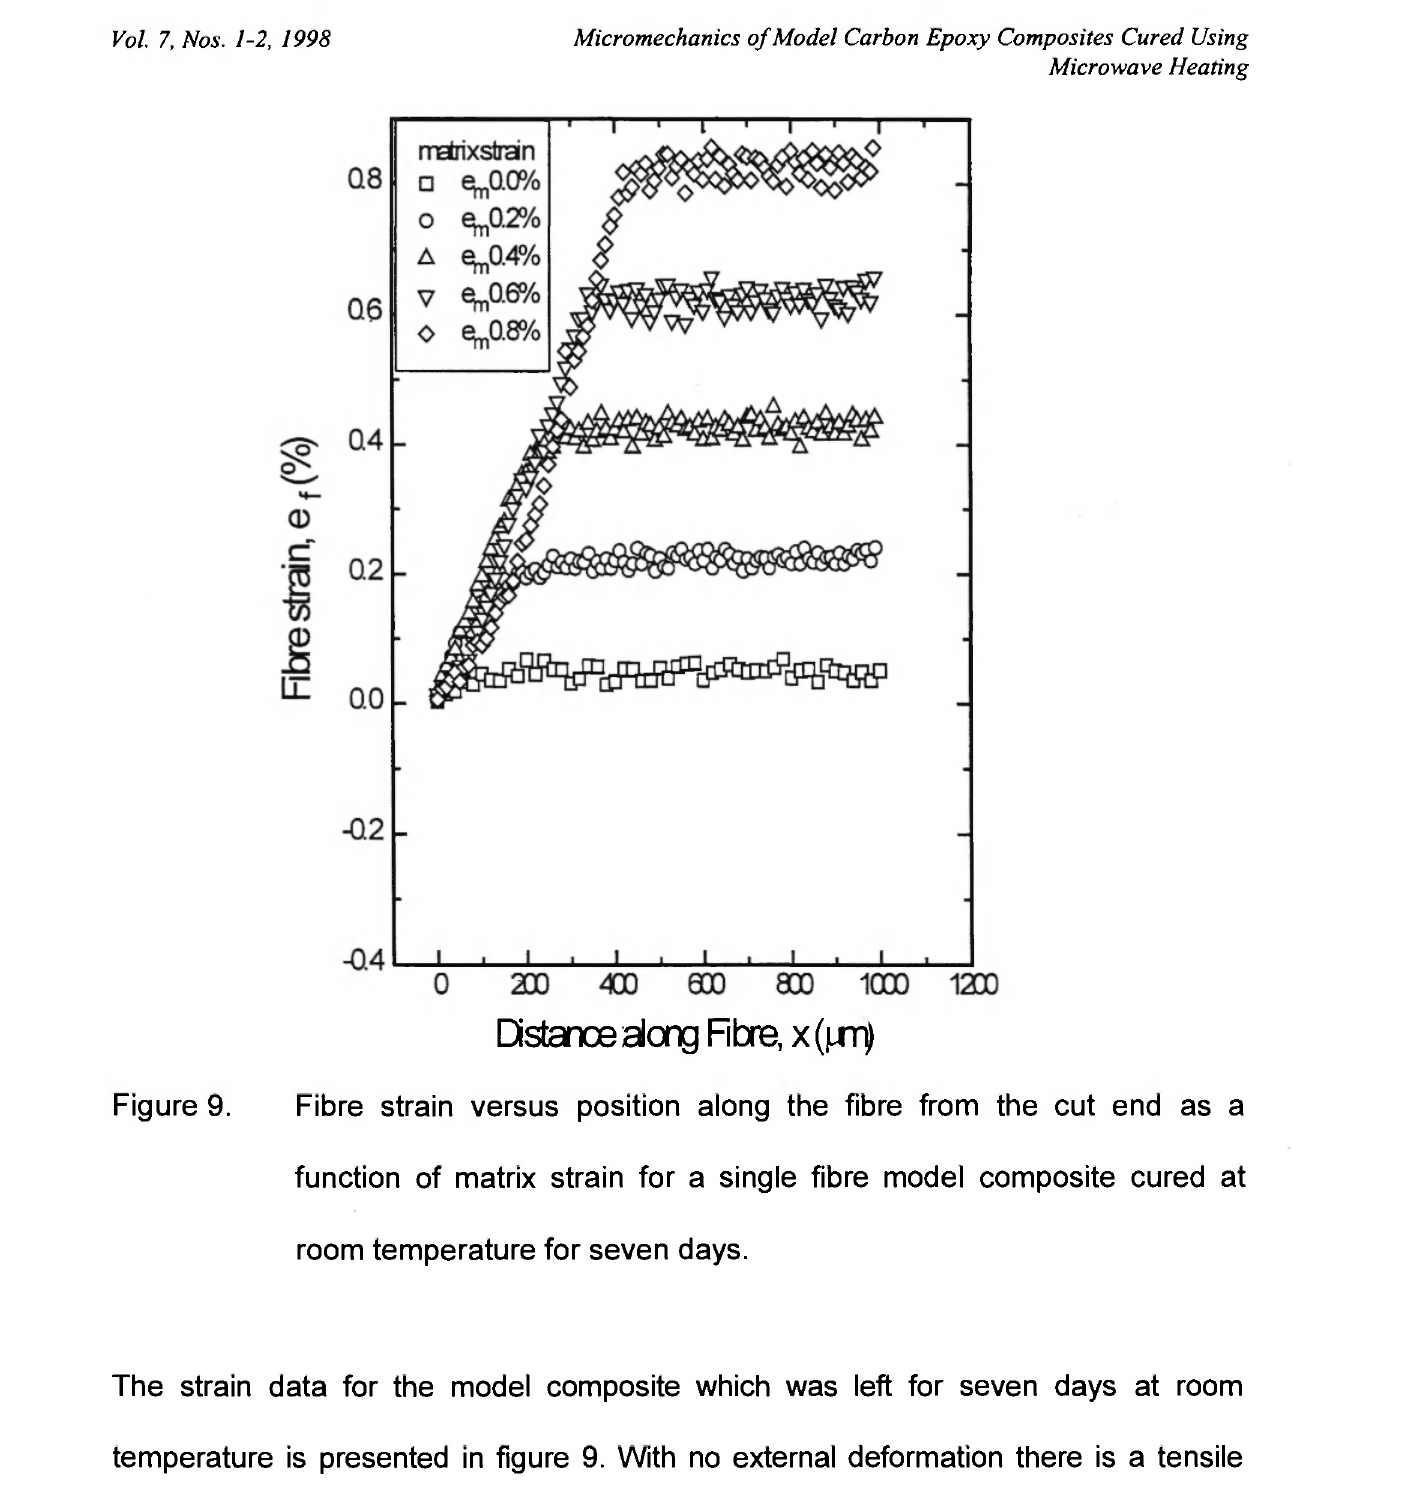
Figure 9. Fibre strain versus position along the fibre from the cut end as a function of matrix strain for a single fibre model composite cured at room temperature for seven